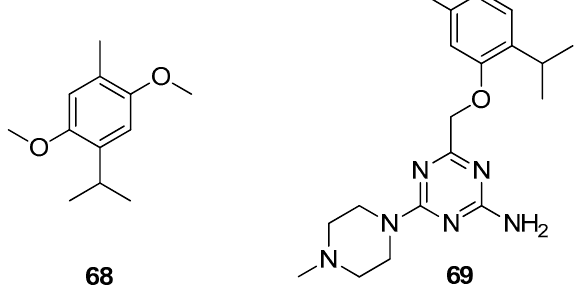
Figure 15. Thymol derivatives with pharmacological activity.